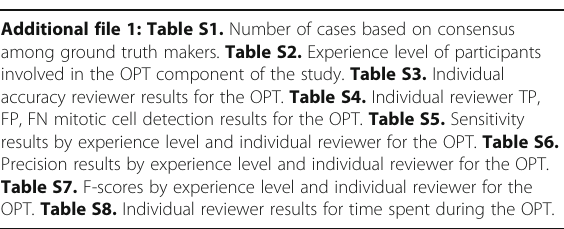
Additional file 1: Table S1. Number of cases based on consensus among ground truth makers. Table S2. Experience level of participants involved in the OPT component of the study. Table S3. Individual accuracy reviewer results for the OPT. Table S4. Individual reviewer TP, FP, FN mitotic cell detection results for the OPT. Table S5. Sensitivity results by experience level and individual reviewer for the OPT. Table S6. Precision results by experience level and individual reviewer for the OPT. Table S7. F-scores by experience level and individual reviewer for the OPT. Table S8. Individual reviewer results for time spent during the OPT.